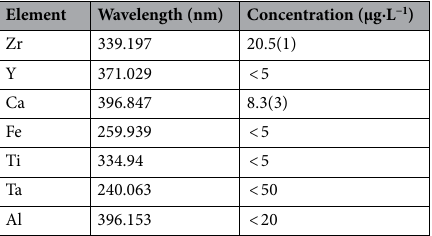
Table 4. Elements measured in the 88 Zr sample obtained from Target 1. Uncertainties in brackets are 1σ standard